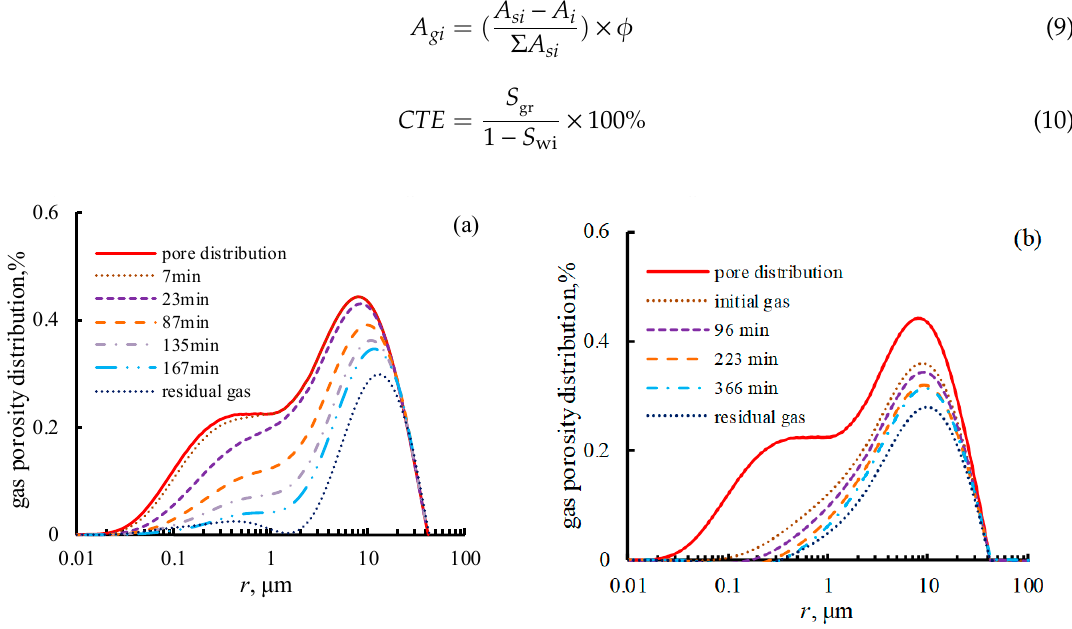
Figure 7. The gas porosity distribution in sample #1-1F during the spontaneous imbibition experiments: ( a ) S wi1 = 0; ( b ) S wi2 = 39.34 ± 1.57%.